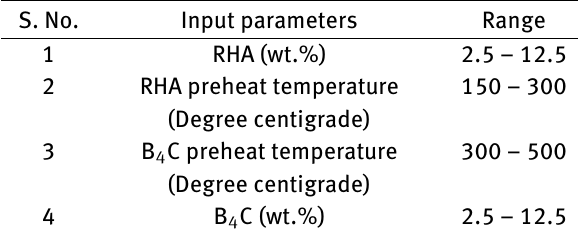
Table 6: Process parameters with their ranges S.